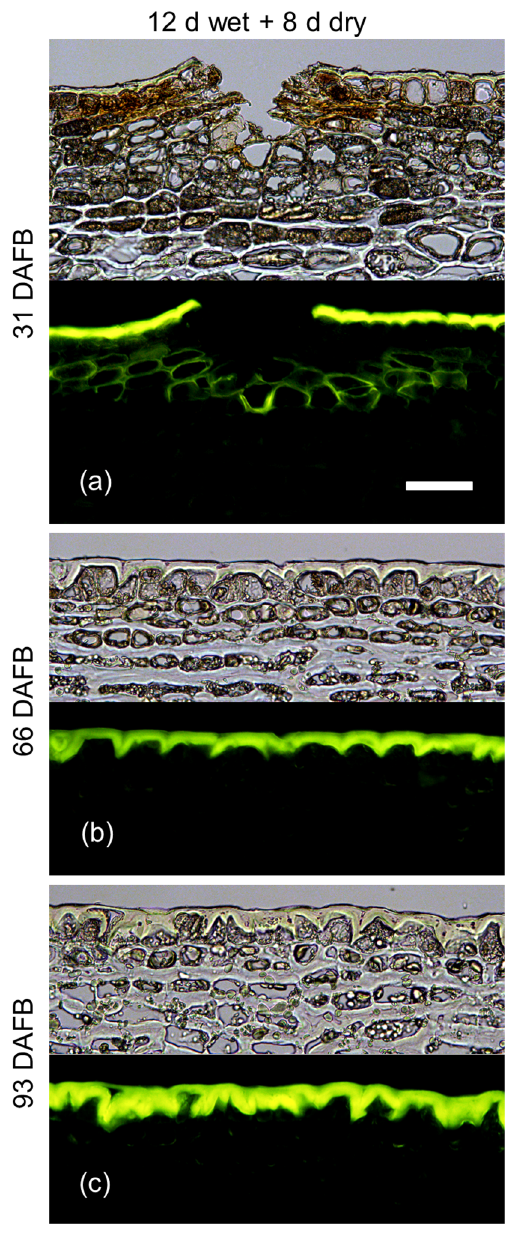
Figure 7. Effect of a 12 d moisture exposure (wet; Phase I) on periderm development in the skin of apple fruit. Cross-sections were prepared 8 d after termination of moisture exposure (dry; Phase II). The fruit surface was exposed to moisture starting at 31 days after full bloom (DAFB) ( a ) or 66 DAFB ( b ) or 93 DAFB ( c ). Cross-sections were prepared from the moisture-treated surface of the fruit. Images were taken under transmitted white light (upper) or incident fluorescent light (lower) (filter module U-MWB) after being stained with Fluorol Yellow 088. The scale bar in ( a ) is 50 µm long and representative of all images in the composite ( n = 3).